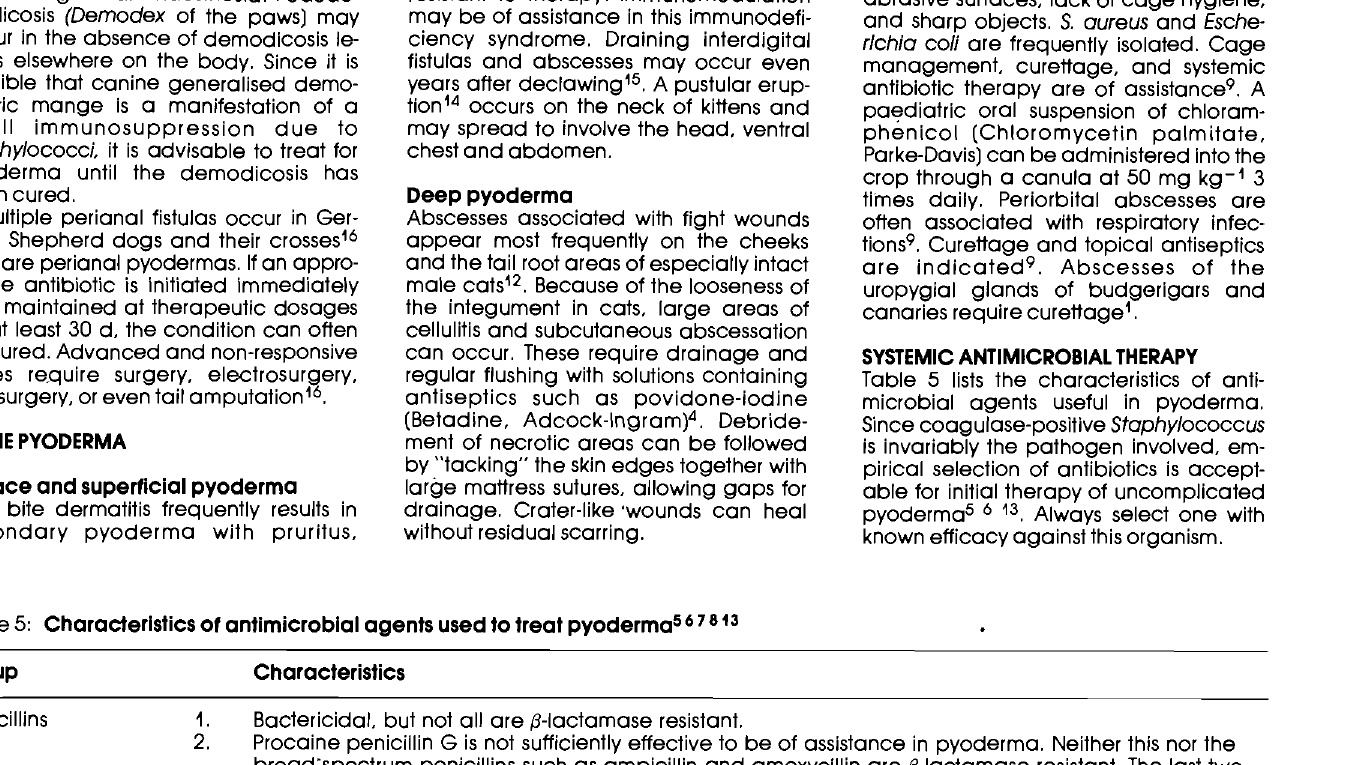
Table 5: Characteristics of antimicrobial agents used to treat pyoderma 5 6 7 813